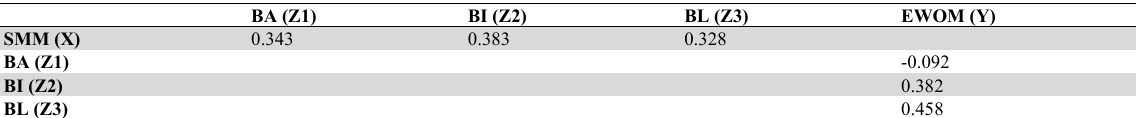
Path Coefficient